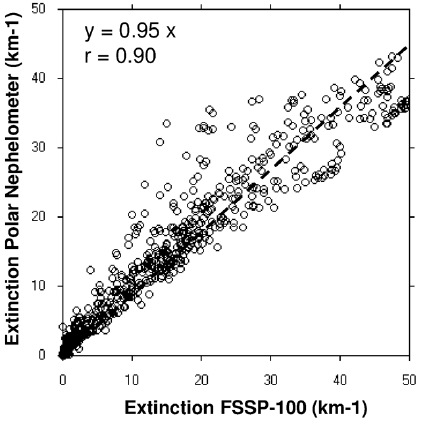
Fig. 2. Relationship between the extinction measurements from the Polar Nephelometer and the FSSP-100. The data correspond to cloud liquid water only (i.e. g > 0.83). ASTAR, 8 April 2007 case study.